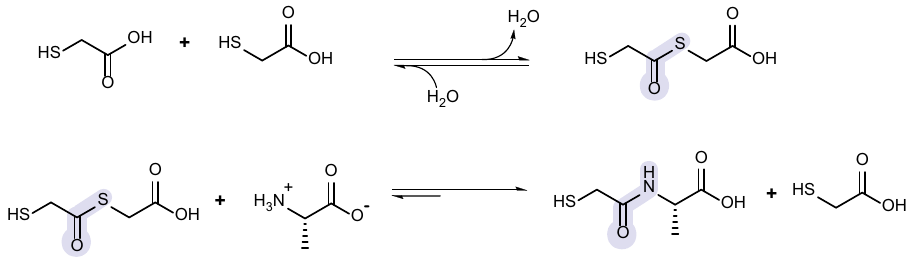
Fig. 1 Proposed acyl substitution reactions for peptide bond formation (amidation) through a thioester-amide exchange. Under conditions of low water activity, mercaptoacids condense to form thioesters, which can be exchanged for amide bonds in the presence of amino acids. Structures are drawn in their predominant form under acidic dry-down reactions (pH